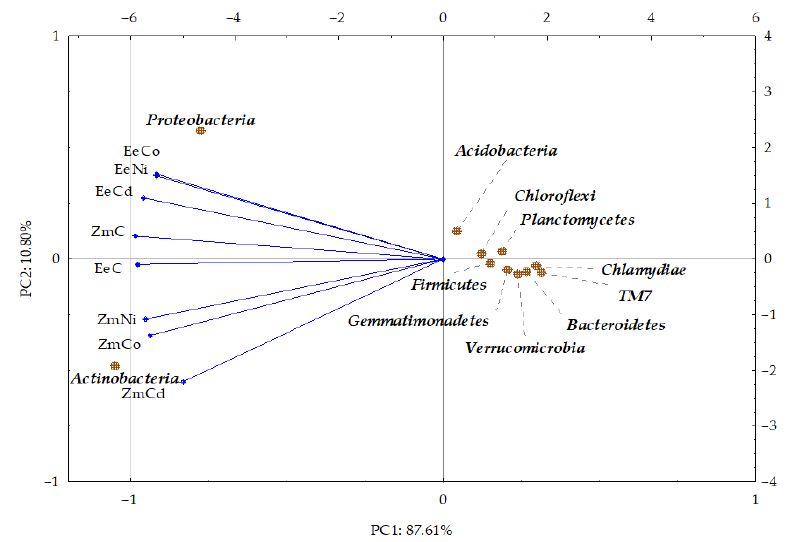
Figure 7. PCA of bacterial phyla colonizing the soil polluted with heavy metals. Ee— Elymus elon-